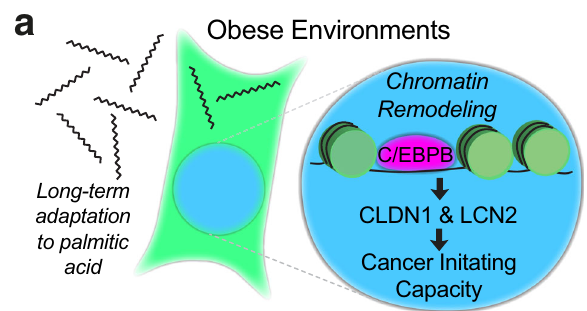
Fig. 7 A schematic model of obese environment on breast cancer- initiating capacity. Long-term adaptation of breast cancer cells to palmitic acid promotes tumor-initiating capacity through increased accessibility of C/EBPB binding motifs, which induces the expression of C/EBPB targets CLDN1 and LCN2